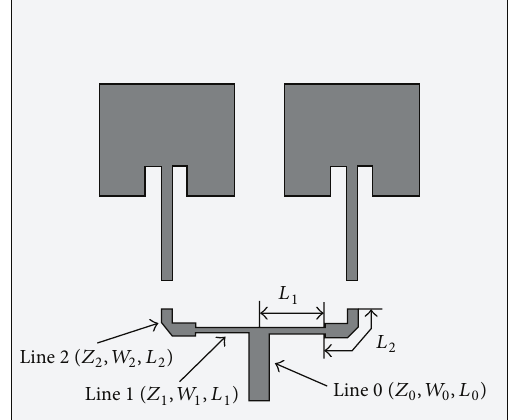
Figure 15: The configuration of the two-element array.